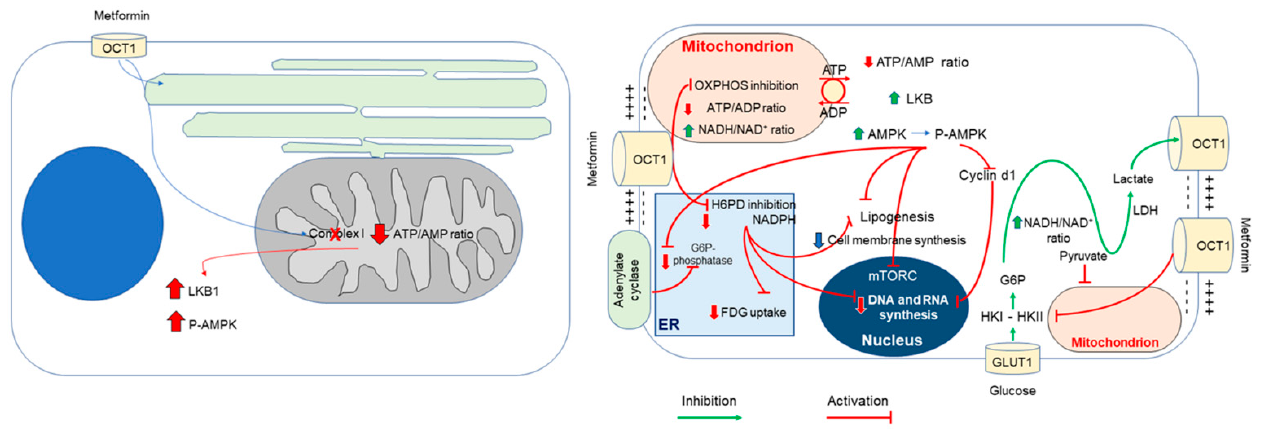
Figure 2. Schematic representation of metformin effects on intracellular glucose metabolism.